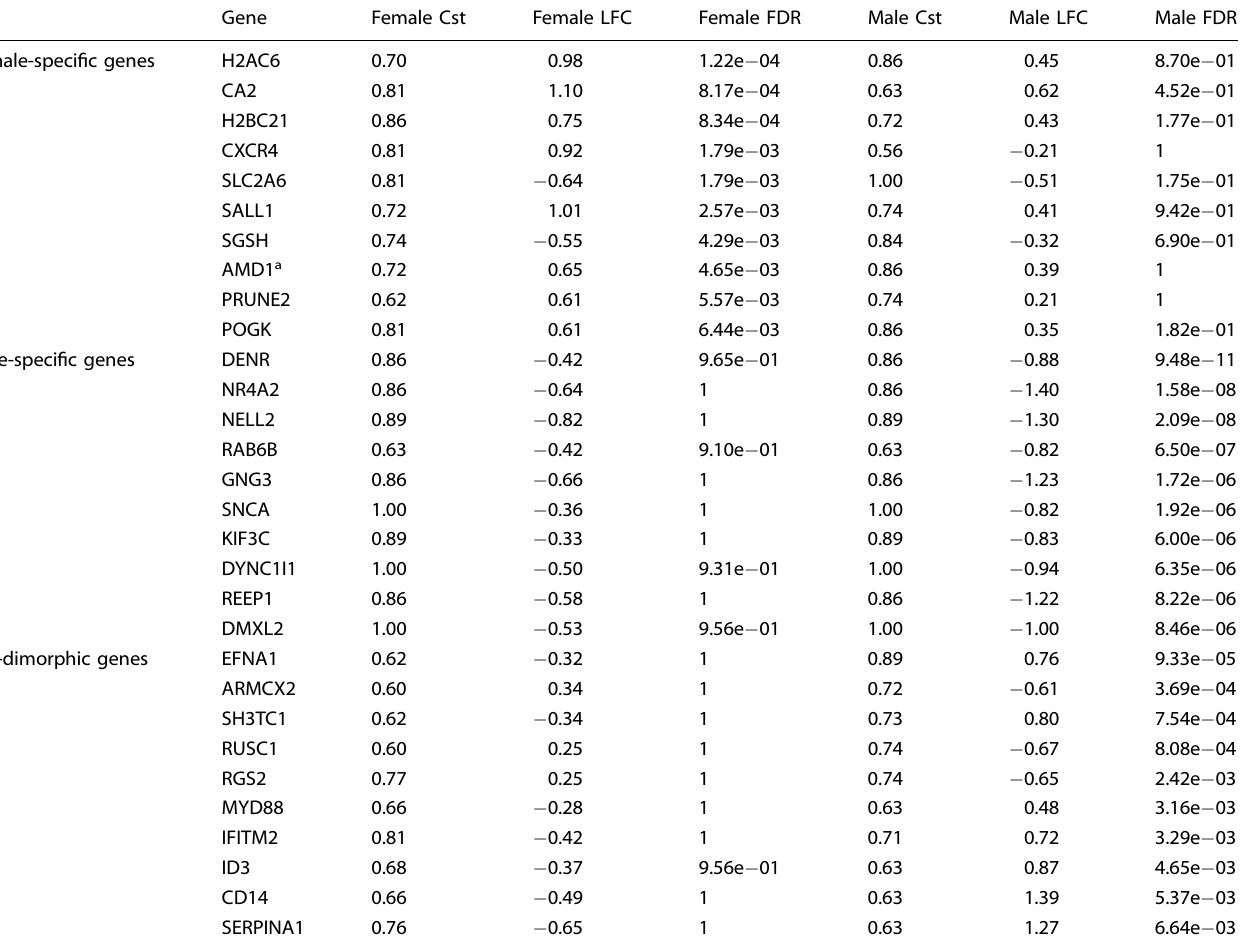
Table 1. Top sex-speci fi c and candidate sex-dimorphic genes.